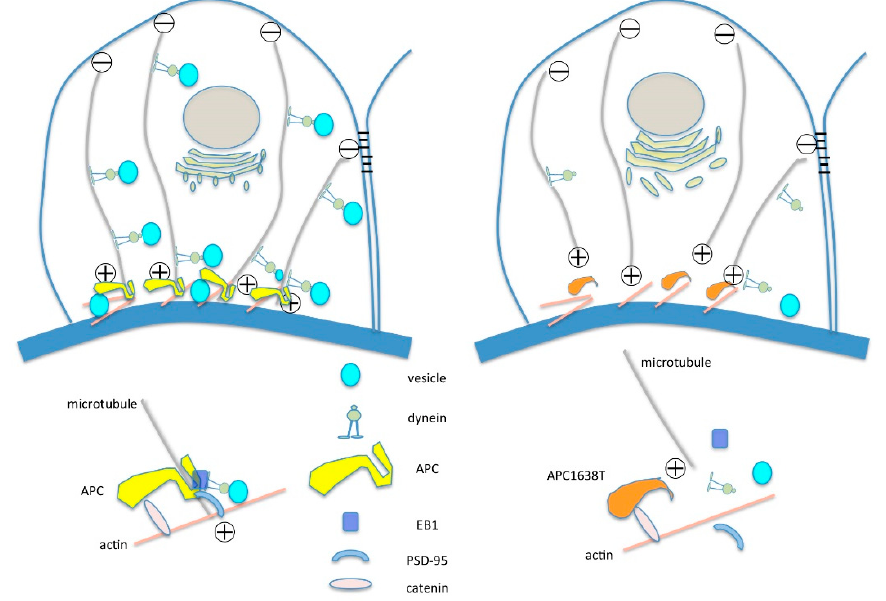
Figure 10. Illustration of molecular bindings of APC C-terminal with microtubule plus-end, PSD-95, EB-1 and cytoplasmic dynein-1 in the WT mice and APC1638T mice.